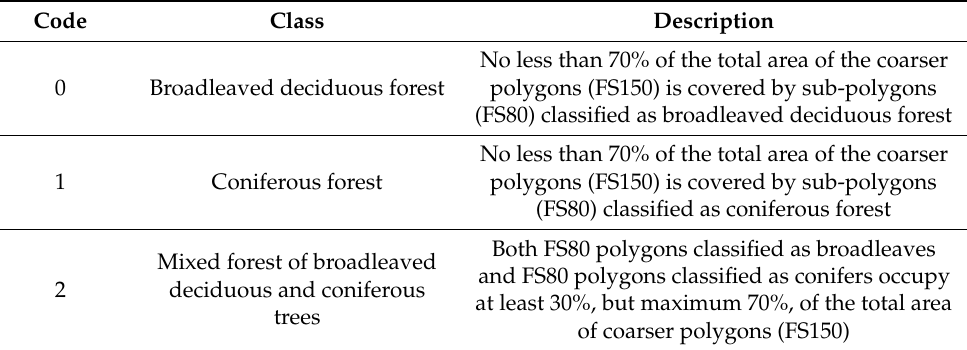
Table 3. Decision-rules for classification of FS150